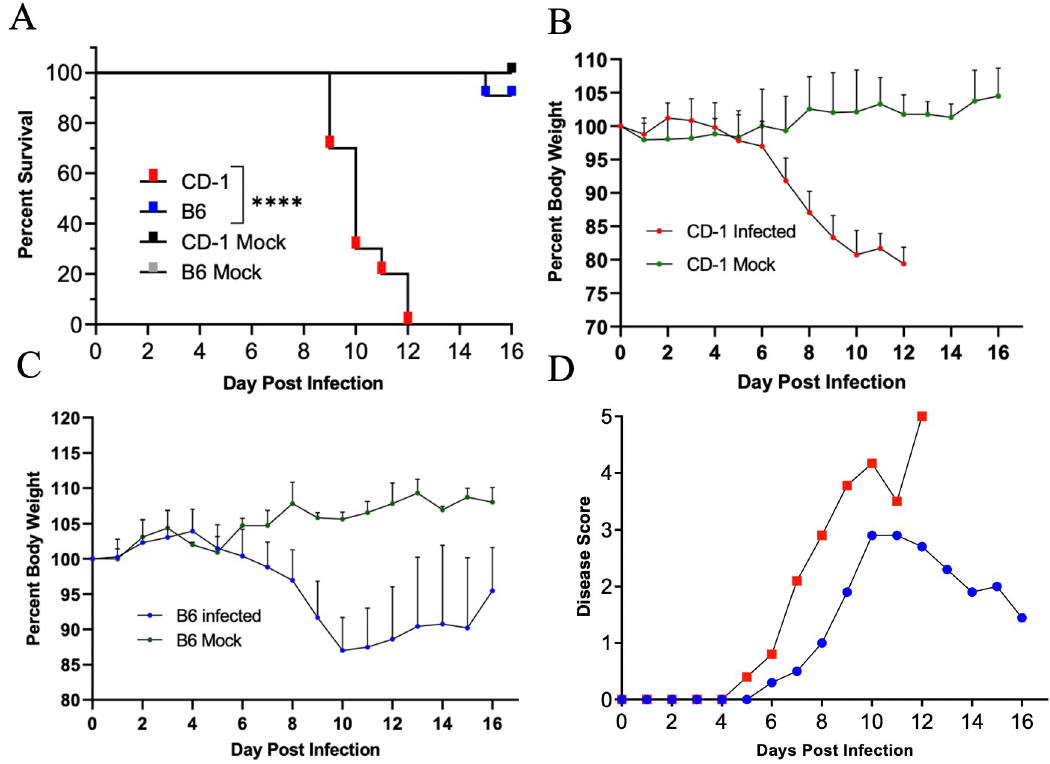
Fig 1. Outbred CD-1 mice were highly susceptible to O . tsutsugamushi infection. CD-1 and C57BL/6 mice were inoculated i.v. with O . tsutsugamushi Karp strain (5.6 × 10 4 FFU, 10/group) or PBS (mock, 3/group) and monitored daily for signs of illness. ( A ) CD- 1 mice began to succumb to infection on day 9, and all died by day 12. Only 10% of C57BL/6 mice died by day 15, with the rest surviving. ( B, C ) Body weight loss in CD-1 mice was rapid and progressive, in comparison to that of C57BL/6 mice. ( D ) CD-1 mice showed disease score on day 5 and had the highest score on day 12. In contrast, C57BL/6 mice started to recover at day 11. Log- ranked (Mantel Cox) test was used for statistical analysis of survival. ���� , p <